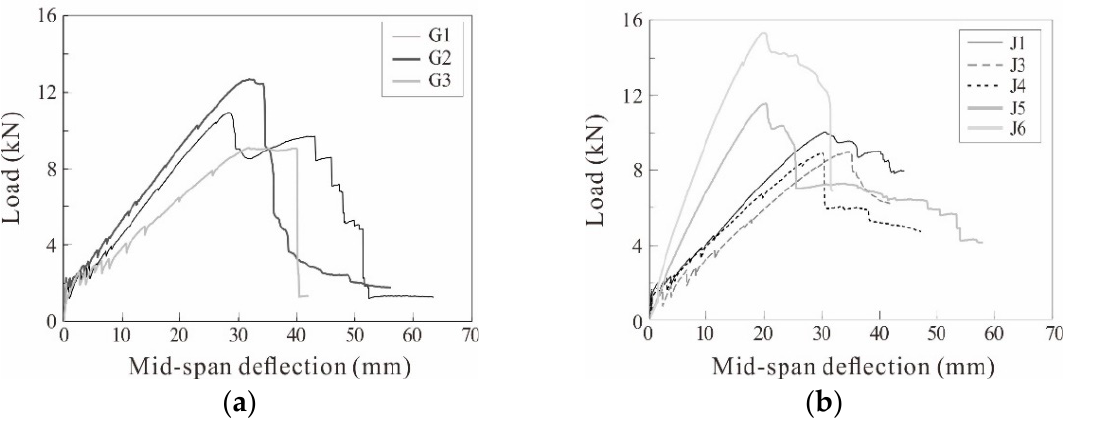
Figure 9. Relationship between the load and mid-span deflection for specimens reinforced with: ( a ) biaxial warp-knitted; and ( b ) cross-laminate structured carbon grids.